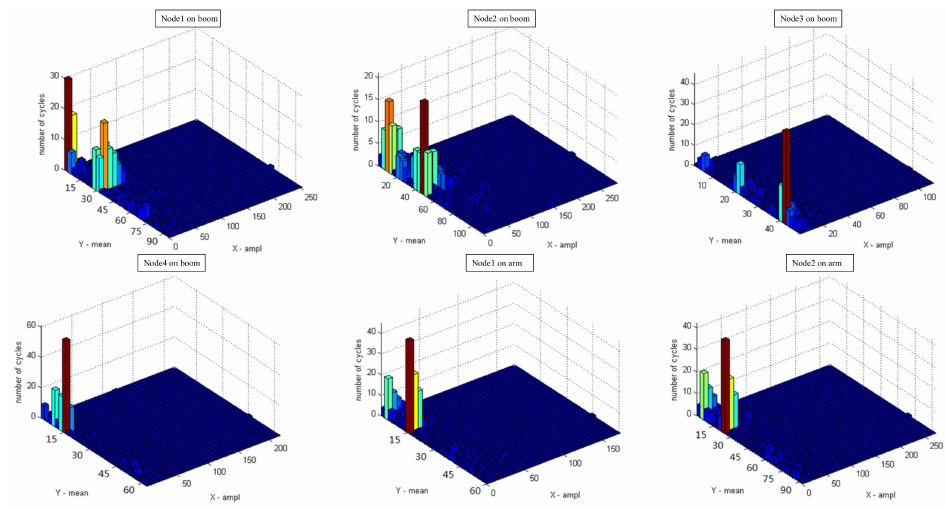
Figure 15. Frequency spectra relevant to the mean and amplitude of stress at the crisis nodes.